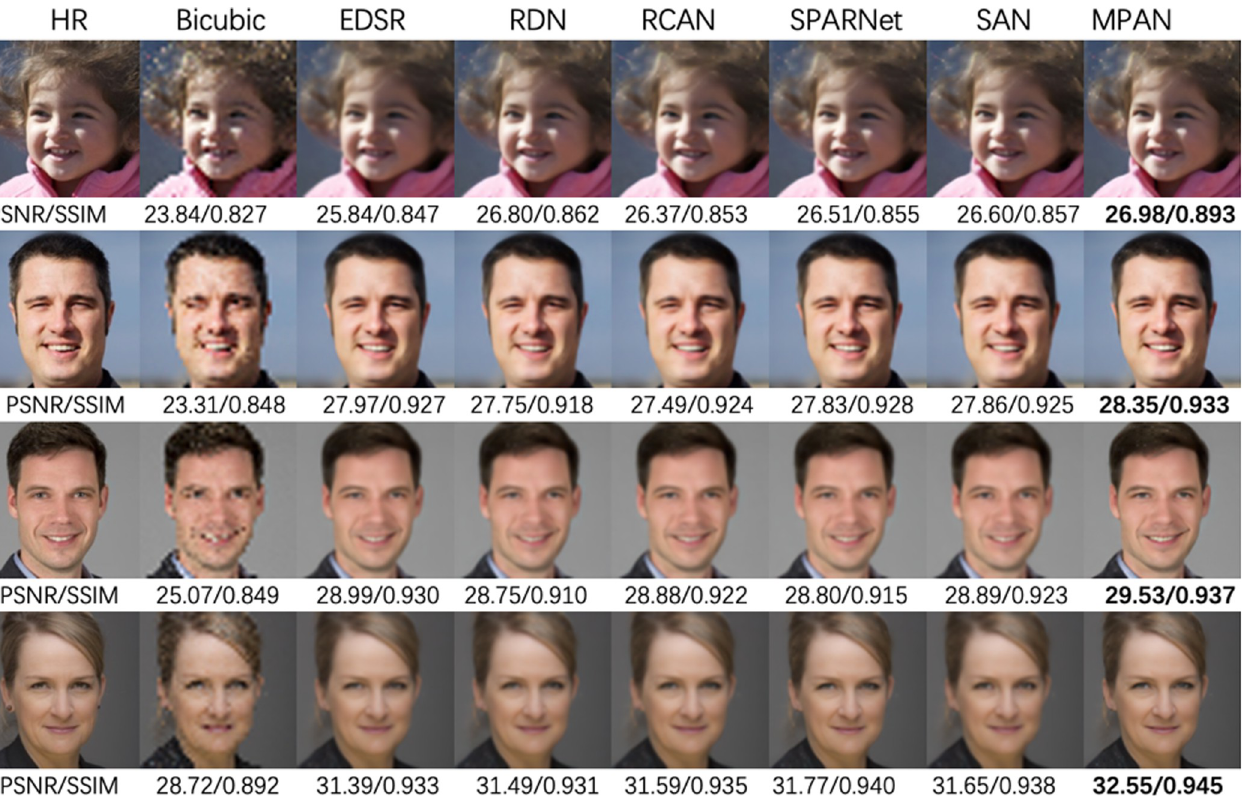
Fig 5. Visual comparison for X3 SR on our face dataset. The best results are bold. Our network achieves superior performance and recovers more face details than previous networks.